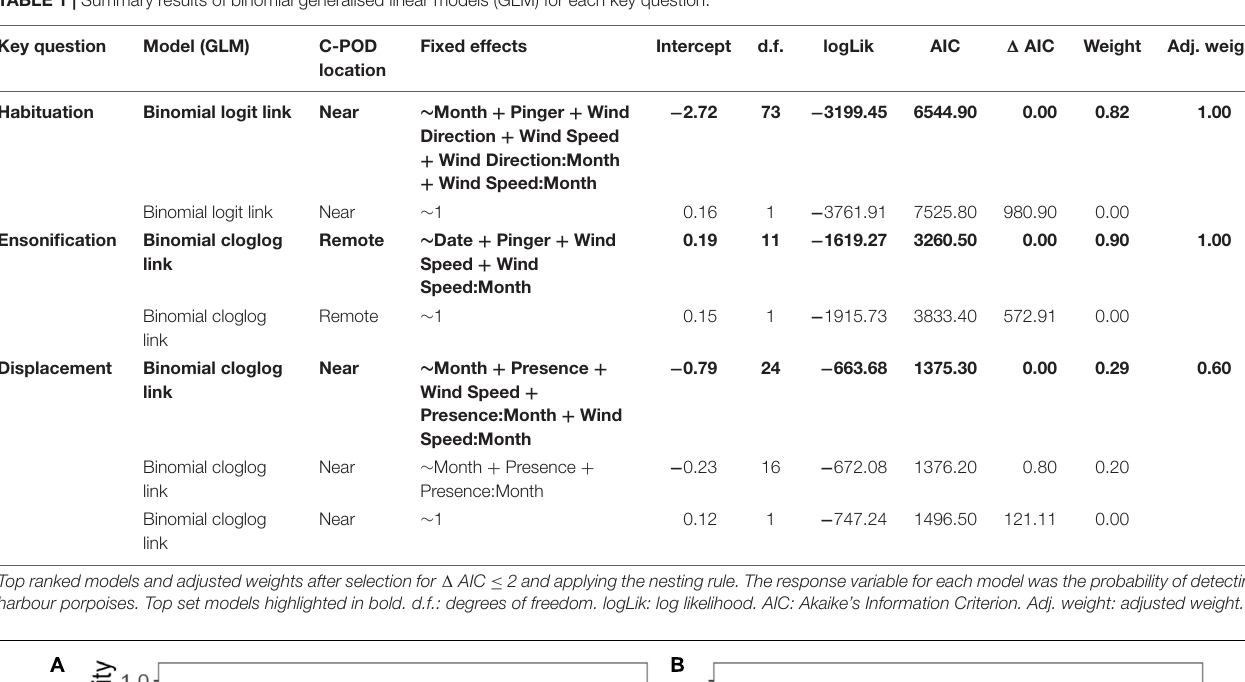
TABLE 1 | Summary results of binomial generalised linear models (GLM) for each key question.